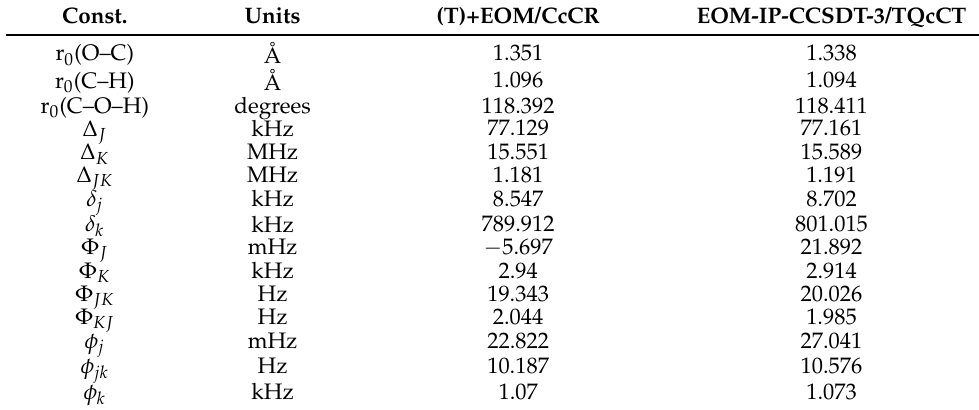
Table A8. Ã 2 B 2 H 2 CO + Distortion Constants and Geometrical Parameters.